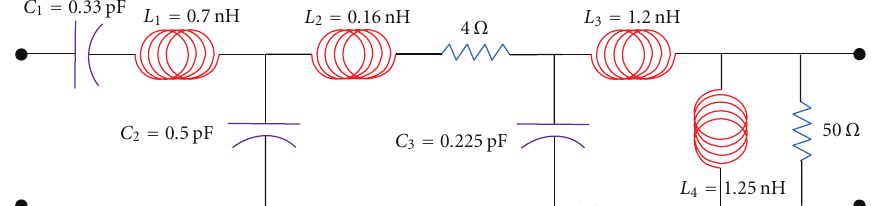
Figure 9: Equivalent circuit for input impedance of coupling monopole at port-1 (excitation